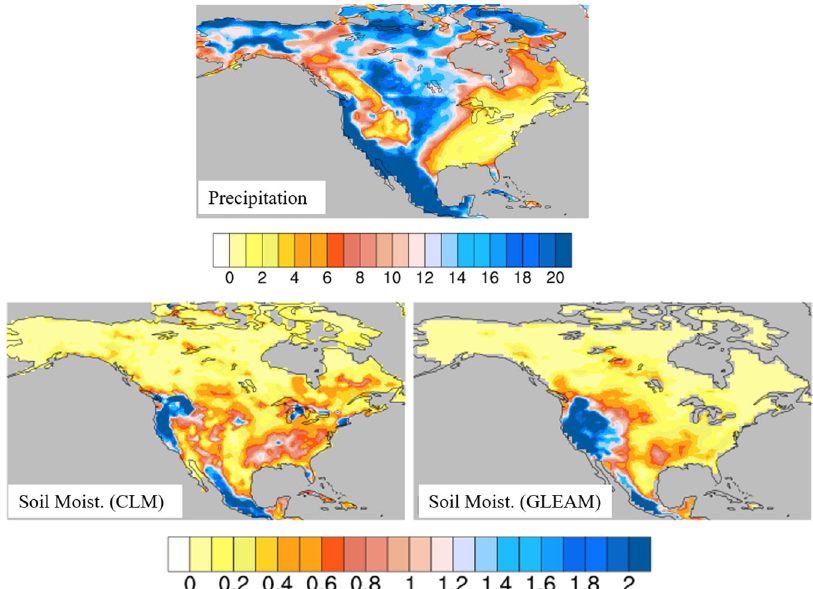
Fig. 5 Apportionment entropy (AE) for the observed precipitation and soil moisture data. Please note that the color scale for the AE of the precipitation is one order magnitude higher than that of the soil moisture. AE 71 is a non-parametric measure of sub-seasonal to seasonal variability in the data — higher AE represents a higher variability in the data (see the “ Methods ” section).